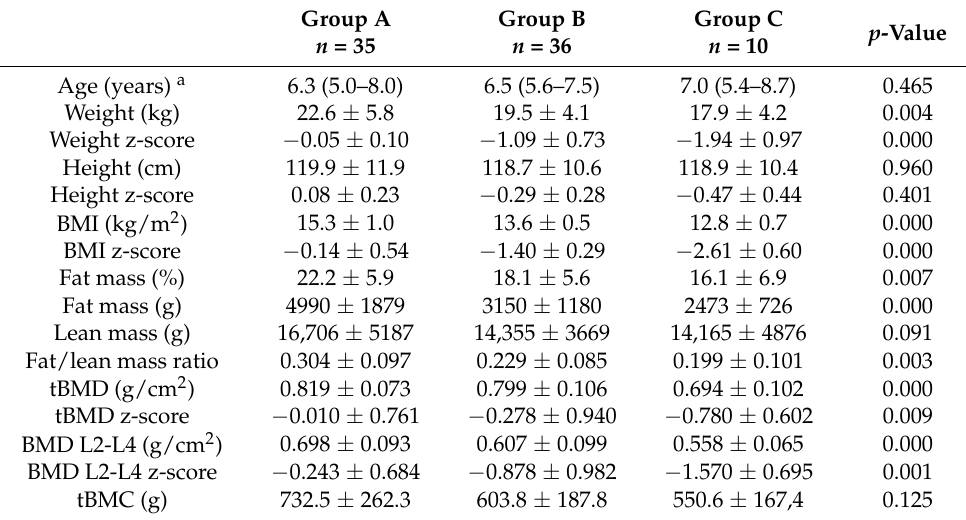
Table 1. Anthropometric parameters in the studied groups of children (group A—BMI z-score be-